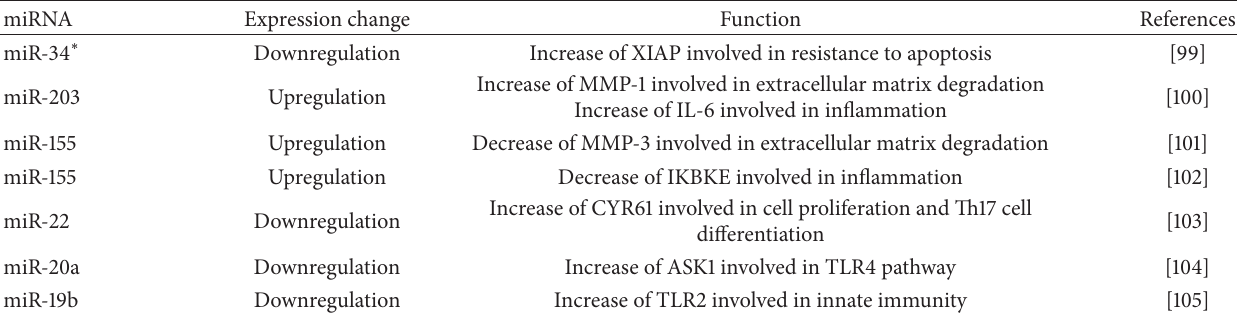
Table 3: Abnormality of miRNAs in